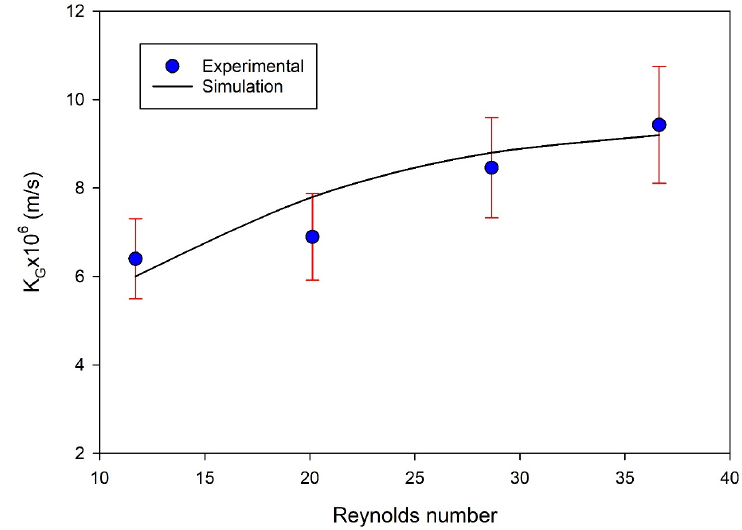
Figure 2. Model validation with the experimental data [35]. The gas phase is fed into the lumen side and the solvent into the shell side (Figure 1a). A comparison of the gas feed rate between the tube side and shell side revealed that introducing the gas to the shell side of the membrane module enhanced the overall mass transfer coefficient compared with gas being introduced into the tube side, attributed to increases in surface contact area and gas residence time in the membrane module (Figure 3). Accordingly, the rest of the results are based on gas flow fed into the shell side and liquid solvent into the tube side (Figure 1b). This configuration matches most of the ex- perimental work performed in the literature, where liquids are introduced to the lumen side of the membrane module for better contact area and residence time [8,33]. The in- crease in the mass transfer coefficient when gas is fed into the shell side is attributed to better mixing and the increase in residence time when the gas flow rate decreases. Our simulation is based on the data available in Table 1, where the gas is introduced into the shell side.